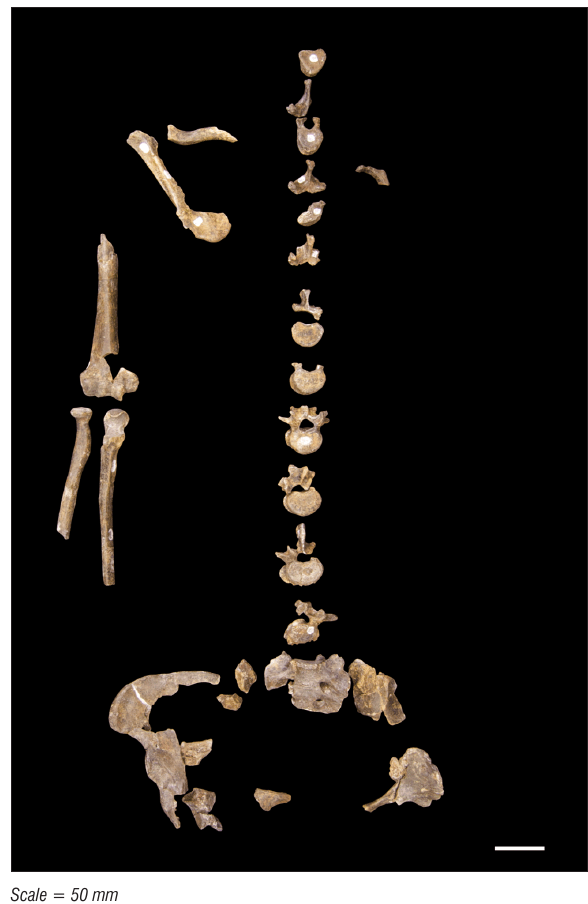
Figure 1: StW 431 – a partial skeleton of Australopithecus africanus discovered at Sterkfontein Caves in 1987 . Stw 431 represented only the third partial skeleton attributed at the time to A. africanus , and represents the only probable male skeleton attributed to this taxon to date.